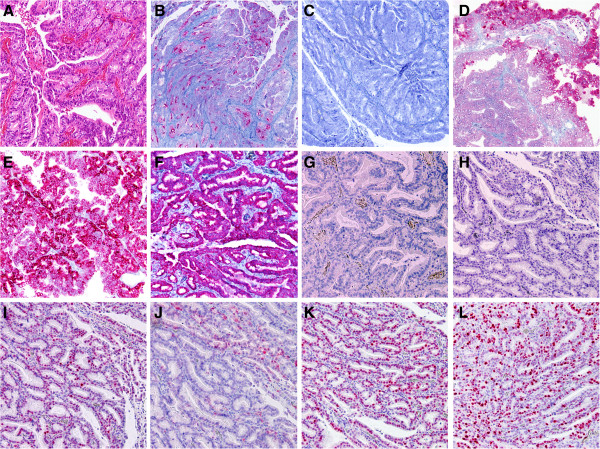
Immunohistochemical findings of the pyloric gland adenoma and adjacent bile duct lesions. The pyloric gland adenoma (A, HE) immunohistochemically expressed focal MUC1 (B), but no MUC2 (C). MUC5AC (D) was positive predominantly in the superficial luminal cell layers, whereas MUC6 (E) was expressed throughout. The tumour cell also expressed vascular endothelial growth factor receptor (VEGF) (F), but no CD10 (G) and CDX2 (H). Nuclear p53 (I) was positive, p16 (J) was focally observed, and p21 (K) was positive. Ki67 (L) was observed in approximately 25% (x100).